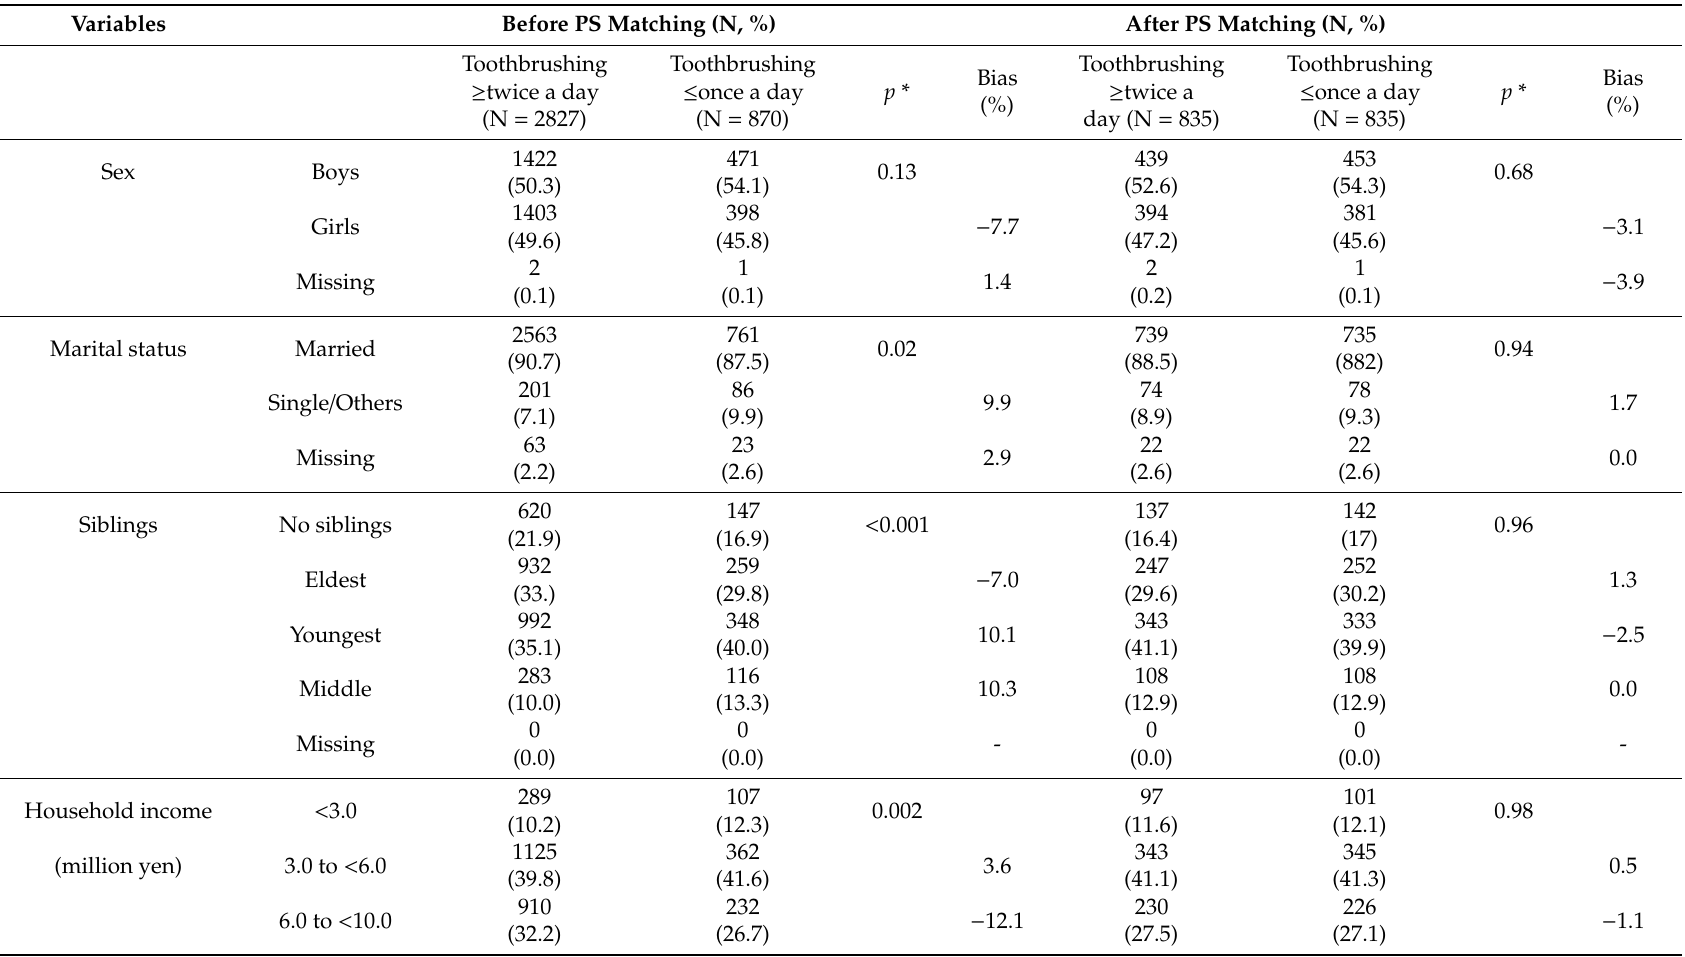
Table 1. Demographic characteristics for toothbrushing frequency in grade 1 before and after propensity score (PS) matching.